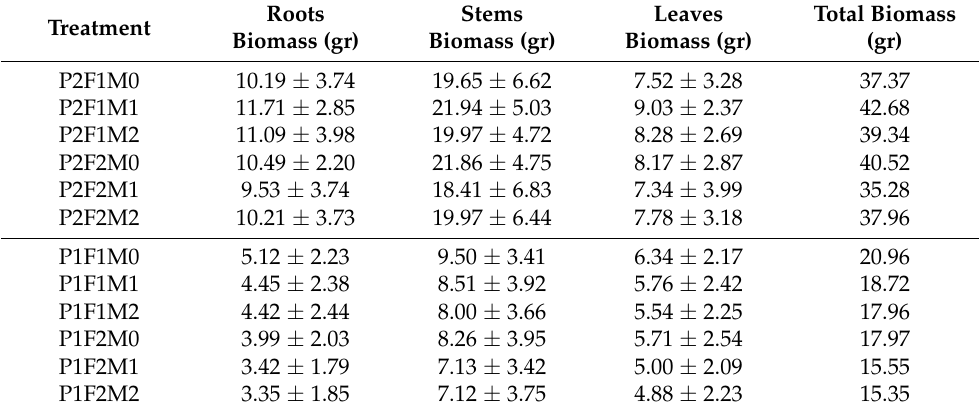
Table 1. Biomass and their standard deviations of Nothofagus alessandrii seedlings by components (root, stem, and leaves) for one- and two-season plants (P1 and P2) with different fertilization (F1 and F2) and MFI management (M0, M1, and M2).